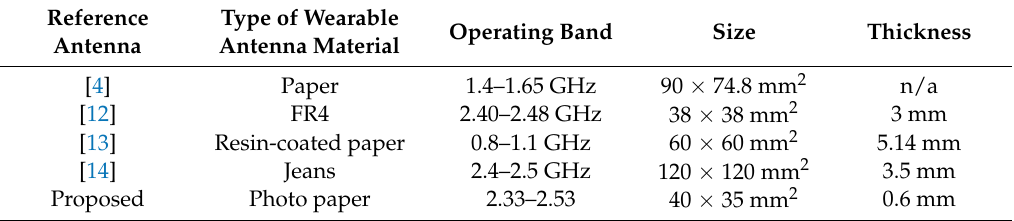
Table 3. Comparison of different wearable